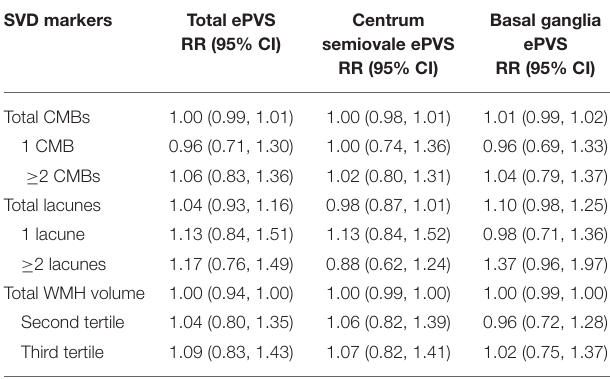
TABLE 2 | Association between severity of SVD and ePVS (Memory